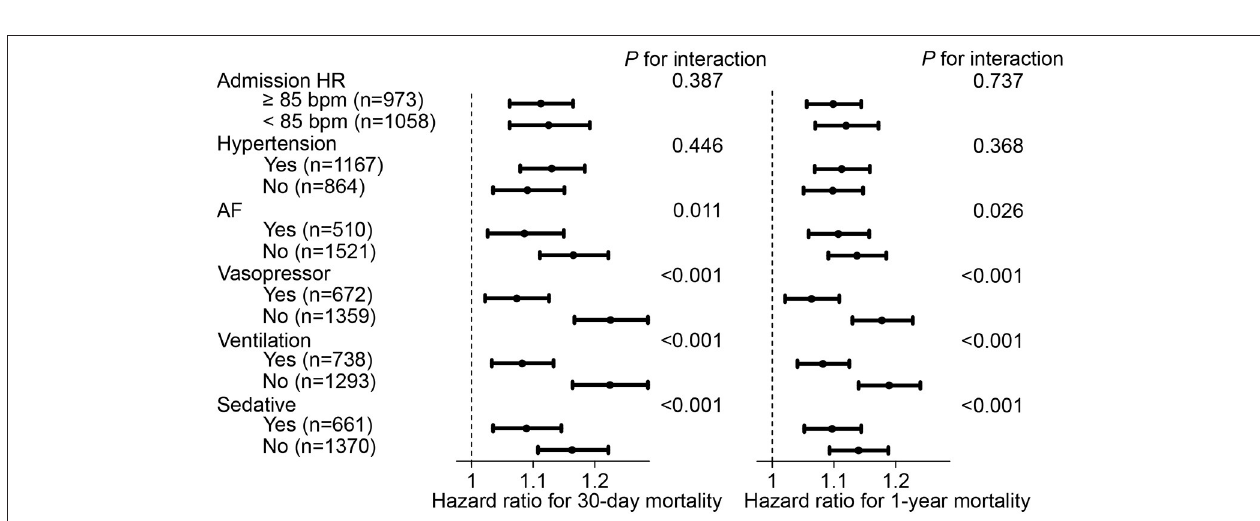
FIGURE 3 | Hazard ratio and 95% CI of HR fluctuation (continuous) for mortality in subgroups. Hazard ratio and 95% CI were calculated along as 10 bpm HR fluctuation increase by Cox hazard regression model using backward process. Model adjusted for age, male, weight, SOFA score, admission HR, sedative, ventilation, vasopressor, CHF, AF, hypertension, liver disease, namely model 5 described above. HR, heart rate; SOFA, sequential organ failure assessment; CHF, congestive heart failure; AF, atrial fibrillation; CI, confidence